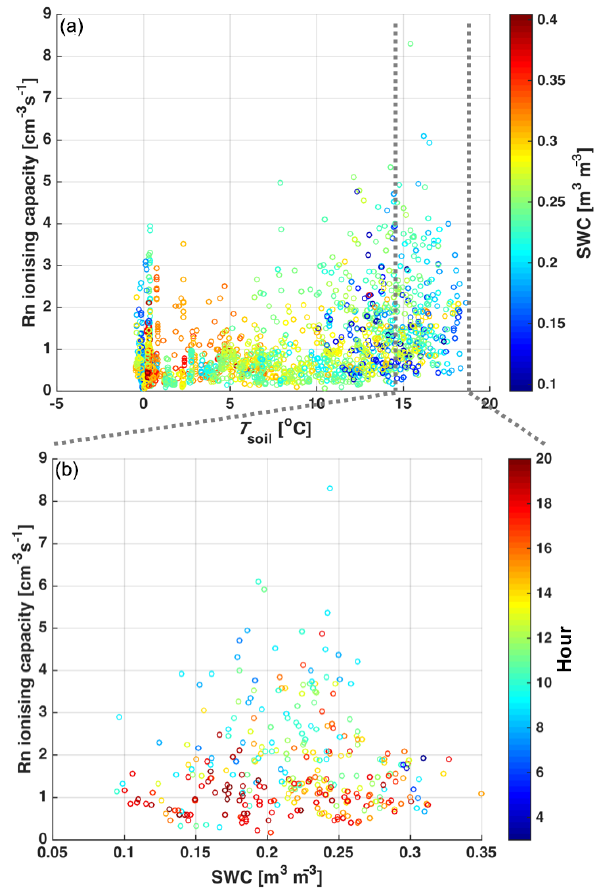
Figure 6. The effect of soil conditions on the radon ionising capac- ity. (a) Radon ionising capacities vs. soil temperatures ( T soil ) in the MLH range of 1000–1500m with soil water content (SWC) shown on the colour scale. Hourly data are presented for 2003–2006 with data in 2004 excluded. According to Ilvesniemi et al. (2010), the quality of SWC data in 2004 was not acceptable. (b) Radon ionis- ing capacities vs. SWCs for soil temperatures larger than 14 ◦ C.